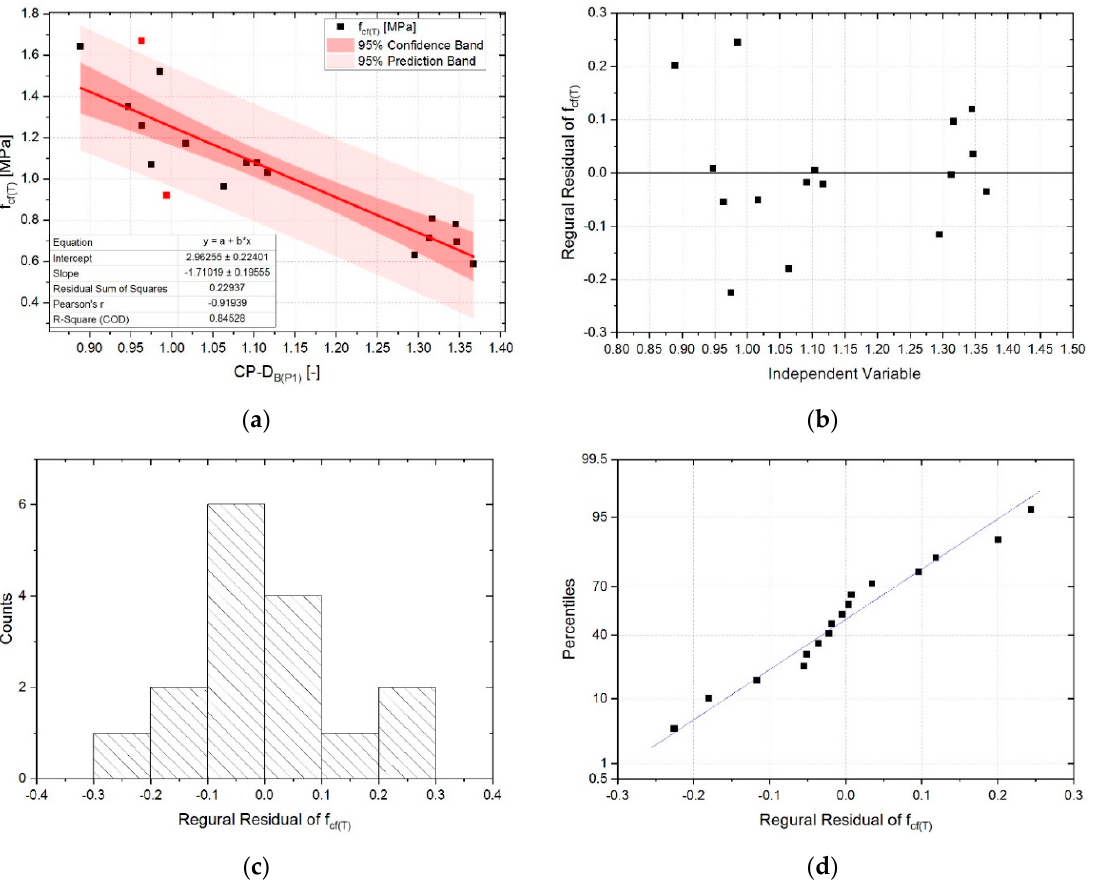
Figure 11. Results of the linear regression analysis for the CP-D B(P1) -f cf(T) relationship together with residual plots: ( a ) regression line (red points—outliers); ( b ) residuals vs. independent; ( c ) histogram of residuals; ( d ) normal probability of residuals.